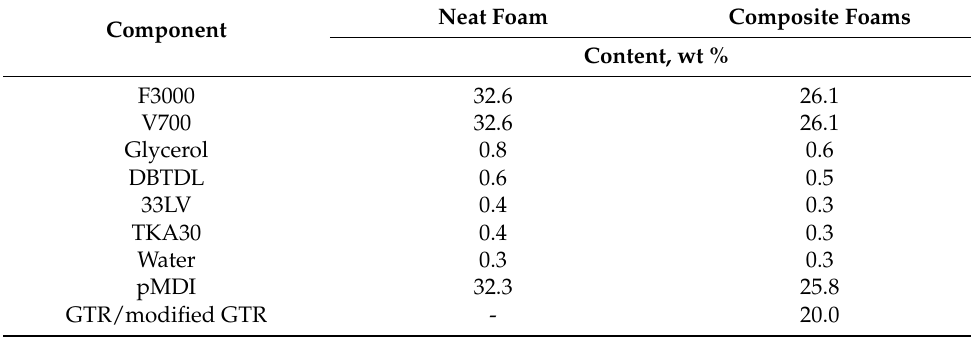
Table 2. Formulations of prepared polyurethane